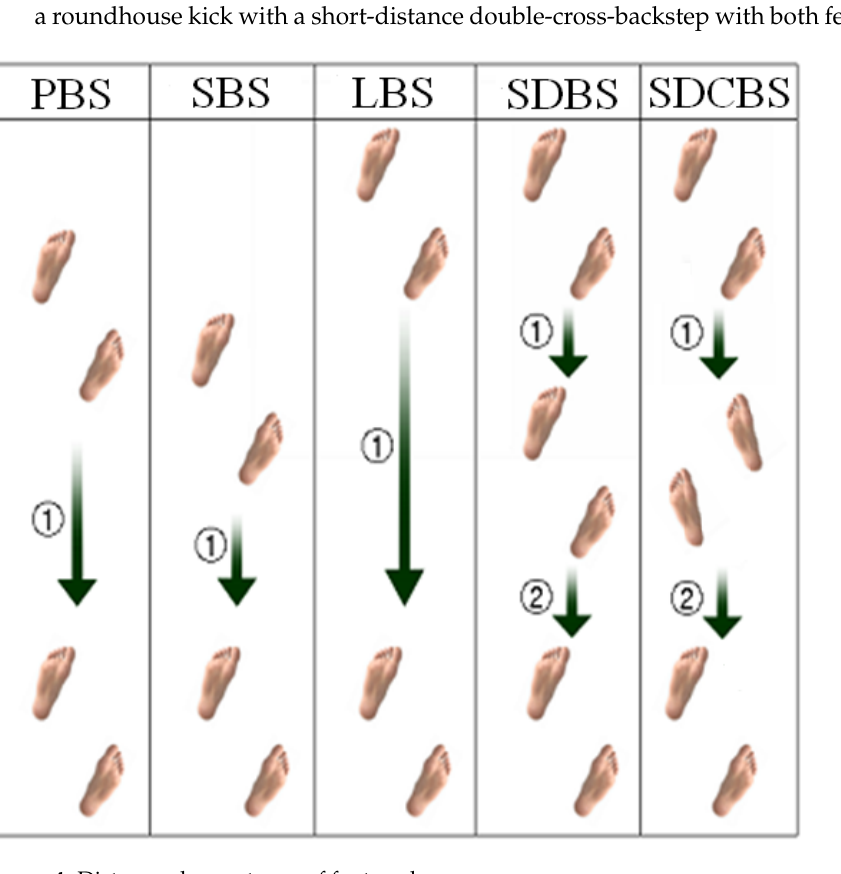
Figure 4. Distance-change types of